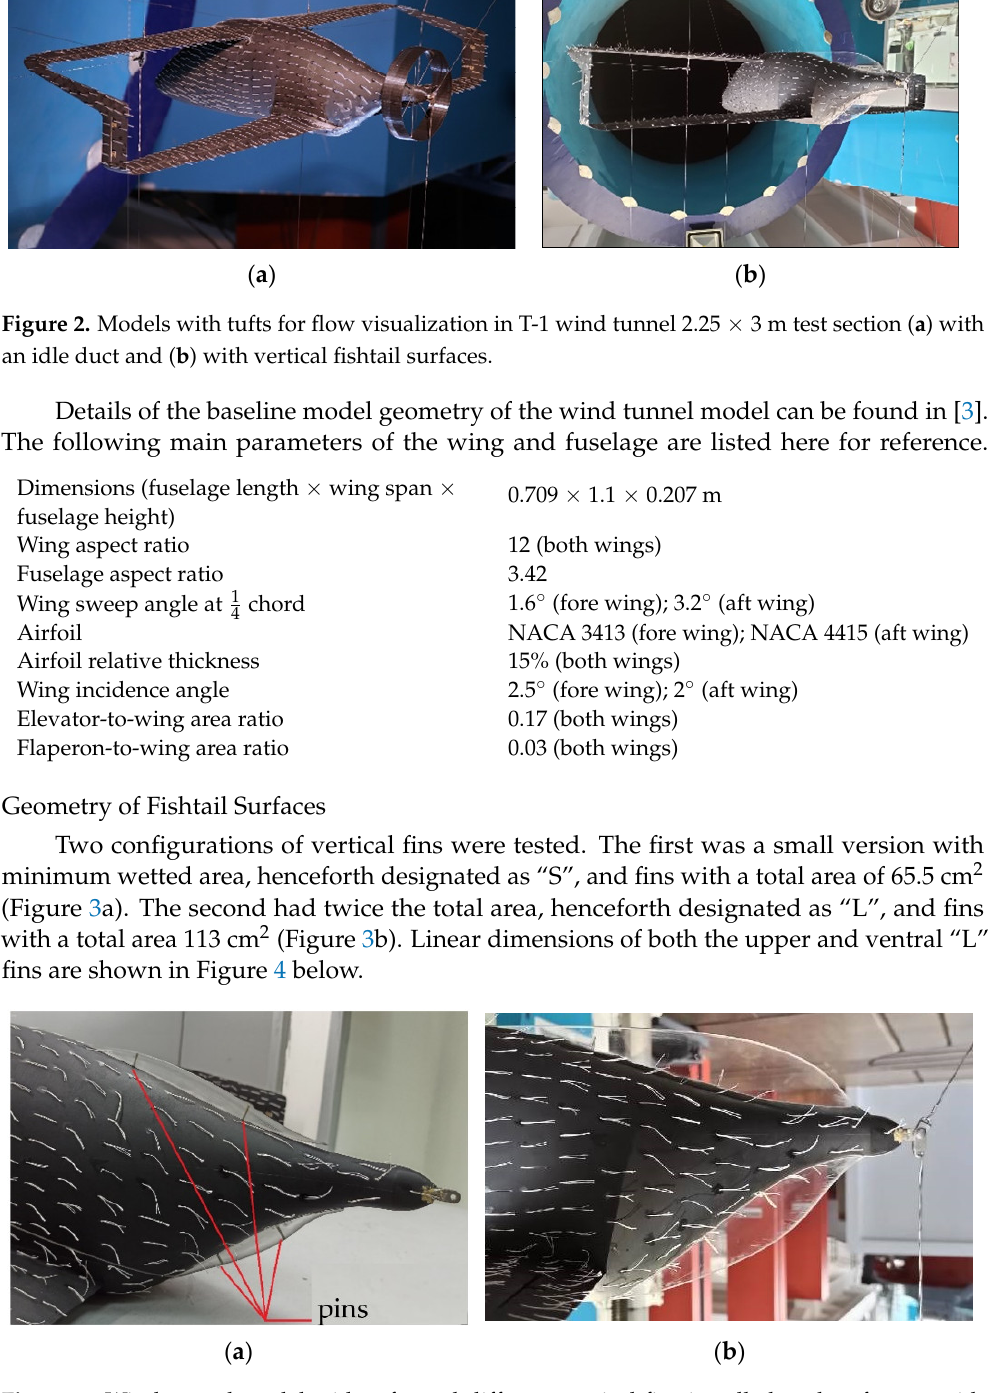
Figure 3. Wind tunnel model with tufts and different vertical fins installed to the aft cone with metallic pins: ( a ) small “S” fin configuration; ( b ) large “L” fin configuration.